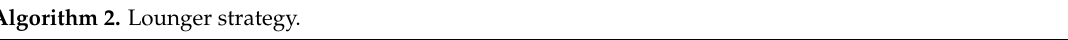
Algorithm 2. Lounger